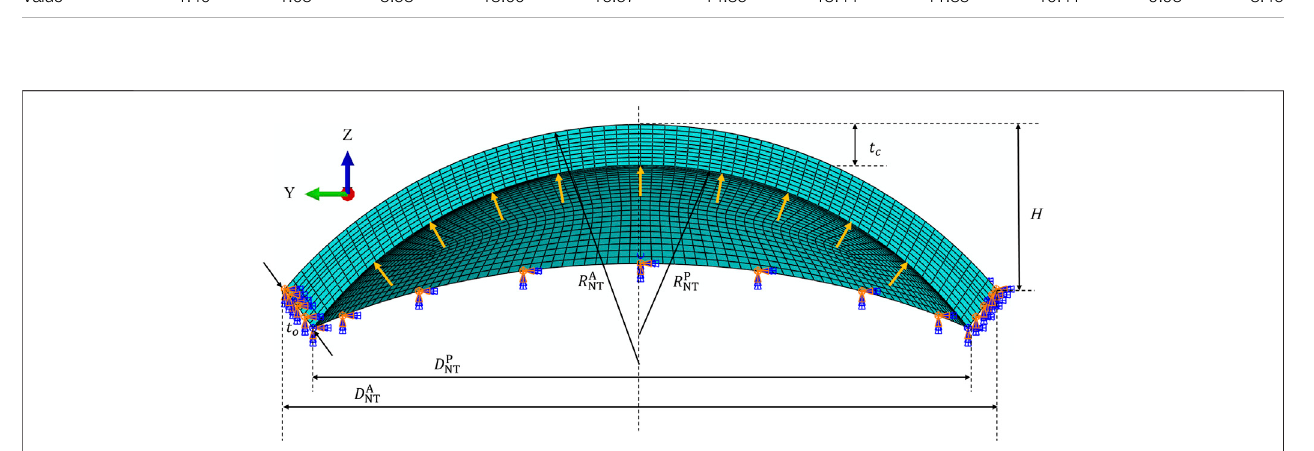
Frontiers in Materials |